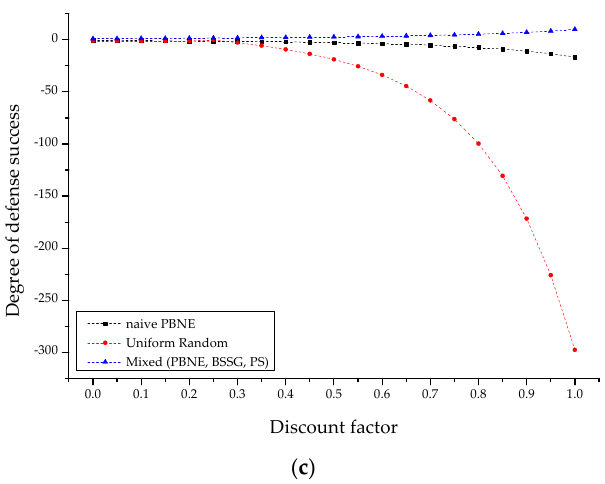
Figure 9. Comparison of the attack success probability in each state with Scenario 2. ( a ) S 1 , ( b ) S 2 , and ( c ) S 3 .